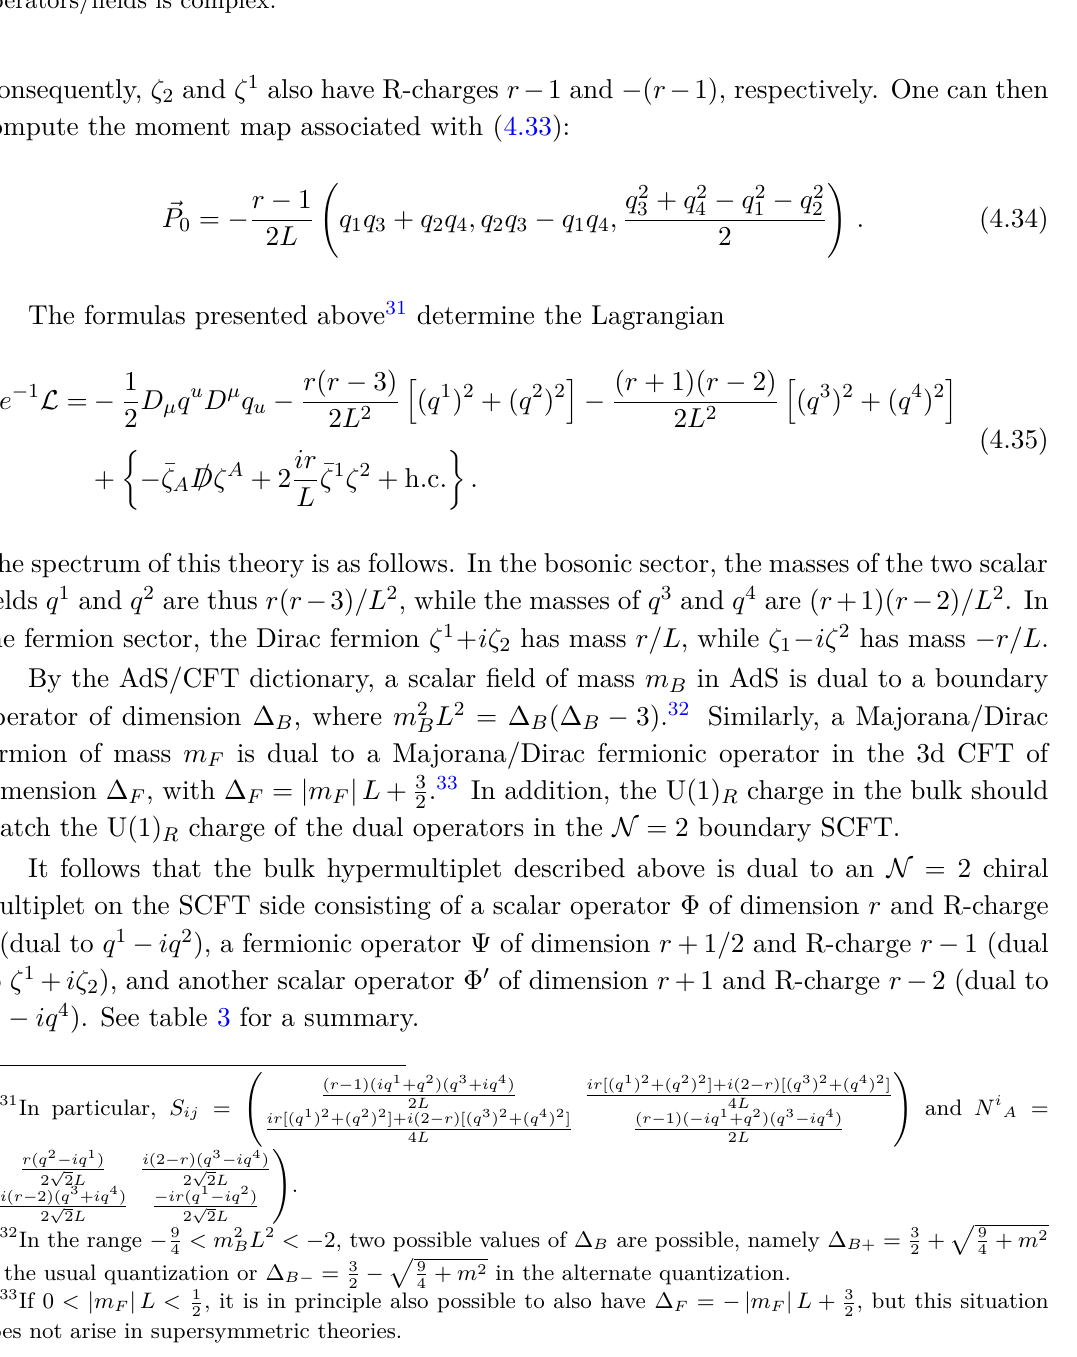
Table 3 . Operator content of a boundary chiral multiplet and its bulk dual. Note that each of the operators/fields is